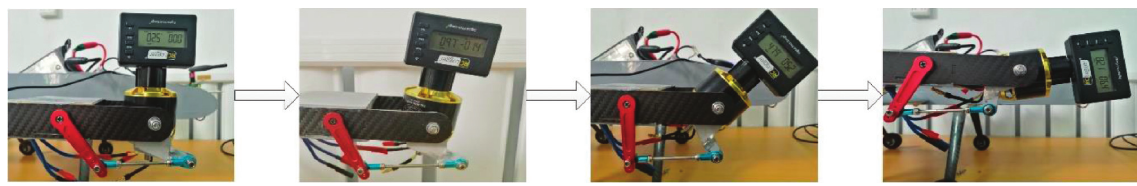
Figure 6: Calibration of the tilting